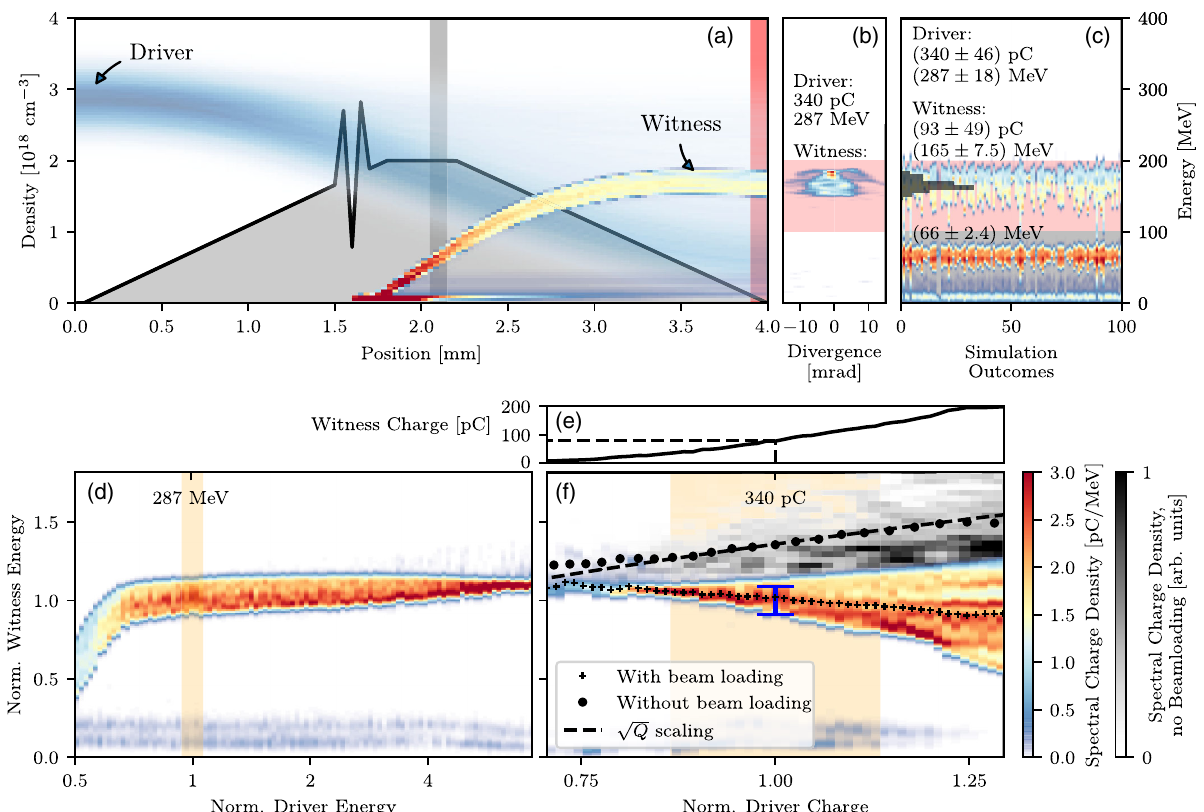
FIG. 3. PIC simulations on stable staged acceleration. (a) Modeled density distribution and evolution of driver and witness energy in the PWFA stage. (b) Angular-resolved witness spectrum for the experimental driver parameters. (c) Set of 100 simulations with randomized variation of driver charge and energy with standard deviation as in the experiment. For comparison the spectra of an earlier simulation step [gray shaded in (a)] are shown where the energy gain resembles the experimental outcome. Panels (d) and (f) show the spectral charge density of the witness for parameter scans of the driver energy and charge. Given that driver depletion can be neglected (here driver energy > 200 MeV), the witness energy does barely depend on the driver energy. Panel (f) shows the spectral charge density of the witness bunch (color scale and black crosses) as a function of the driver charge. With increasing driver charge the witness charge increases (e), the witness spectrum broadens, and its mean energy slightly decreases. For comparison the energy gain of a test bunch in an unloaded wakefield with equal driver is plotted (gray scale and black dots). In both scans the experimental working point is indicated by the orange shaded area. The simulation outcome in (d) and (f) is normalized to the experimental working point in (b). For comparison the experimental standard deviation of the witness energy is plotted in blue. Note that the experimental result is normalized